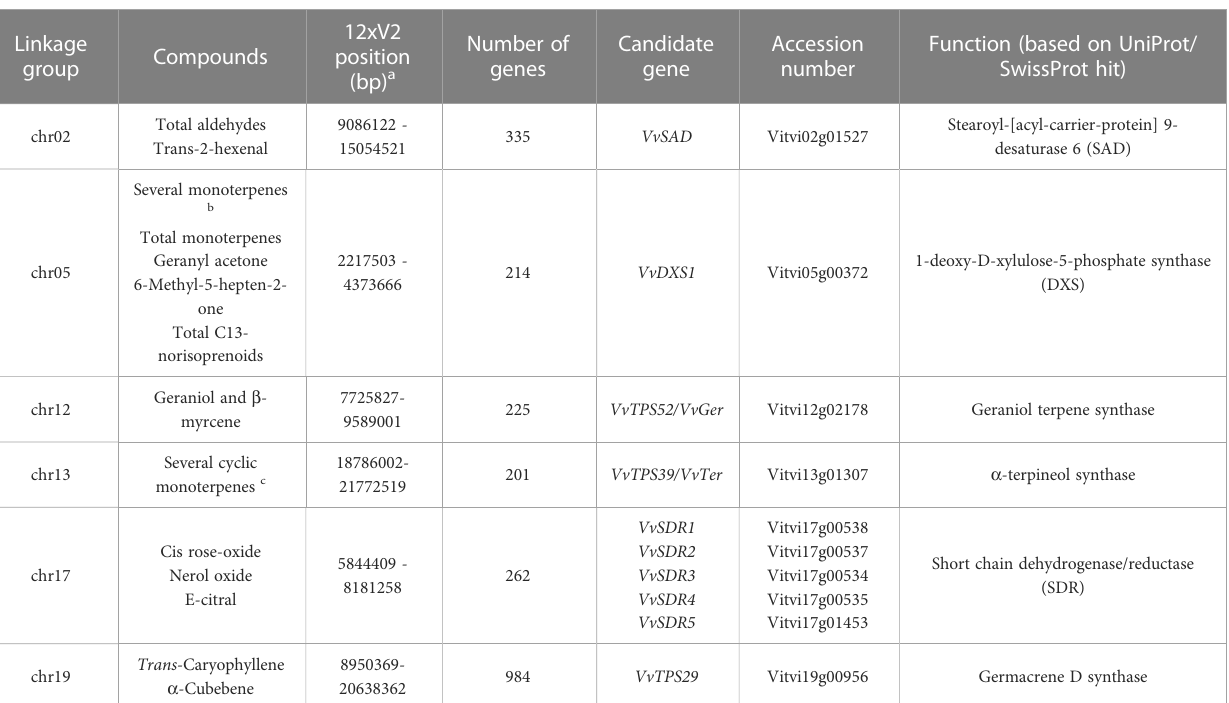
TABLE 1 List of candidate genes for signi fi cant QTLs associated with VOCs.